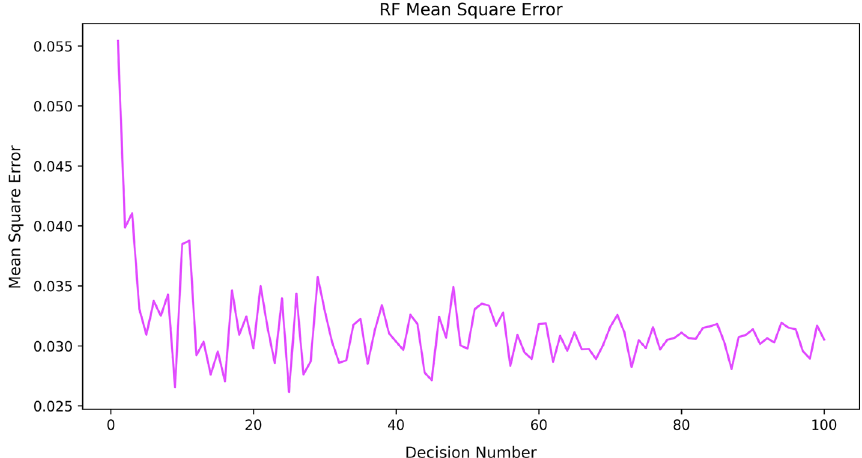
Fig. 2 RF mean squared